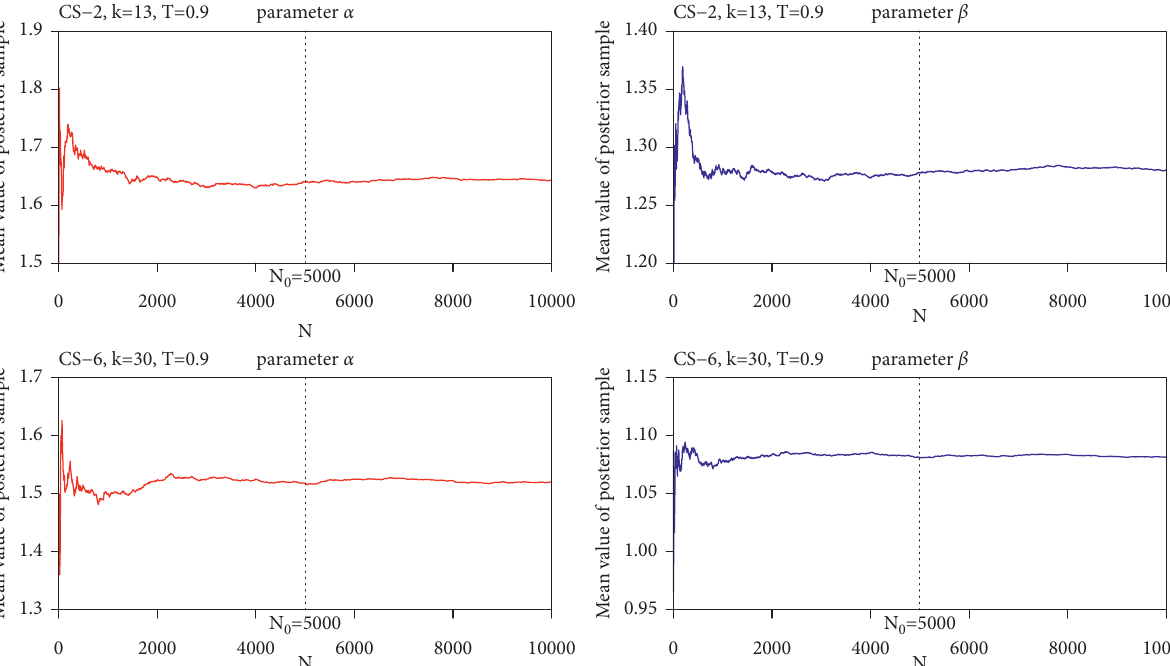
parameter α CS−6, k=30, T=0.9